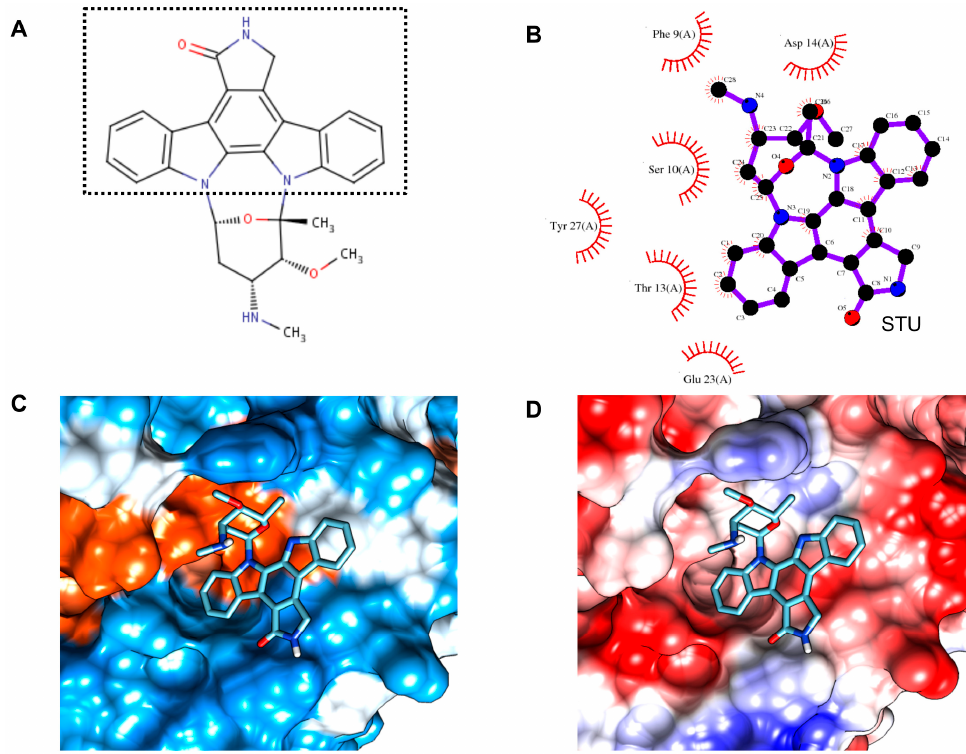
Figure 7. Structural and detailed view of interaction of compound with CsTegu20.6. ( A ) STU (staurosporine). The fused indole and carbazole ring is indicated with a dotted rectangle; ( B ) The binding mode of STU in the CsTegu20.6 binding pocket obtained from GalaxySite [48]. Putative inhibitor and residues that are in close contact with each other are indicated in 2D diagrams. The residues, marked with red spoked arcs, involved in hydrophobic interactions with the compound; ( C ) Hydrophobic surface. The binding pocket is colored from blue for the hydrophilic region to orange for the hydrophobic region; ( D ) Electronic surface. The binding pocket is indicated from blue for the negatively-charged region to red for the positively-charged region.